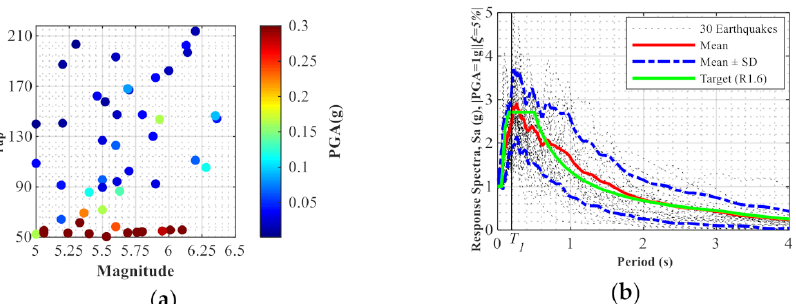
Figure 13. ( a ) Scatter plot and ( b ) response spectra of input ground motions (GMs) matched with the design response